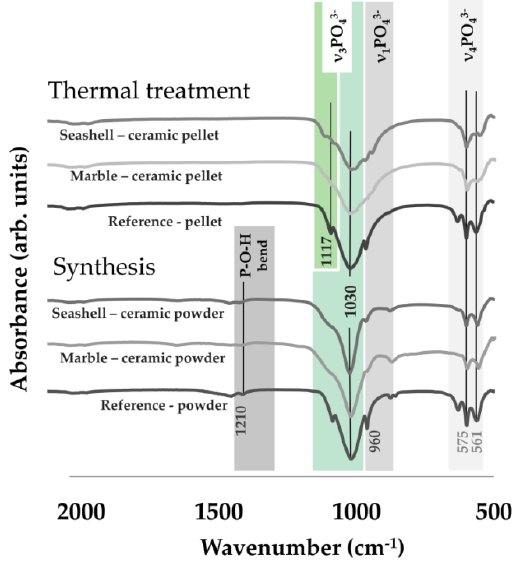
Figure 3. Representative FT-IR spectra for seashell, marble and reference material derived products.